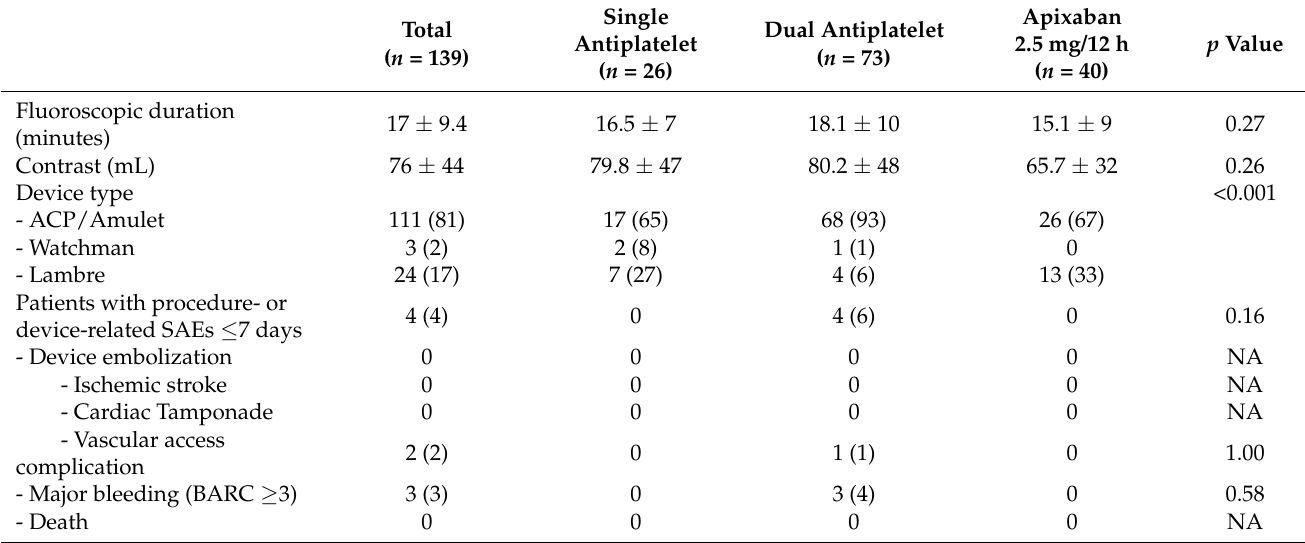
Table 2. Procedural characteristics and in-hospital